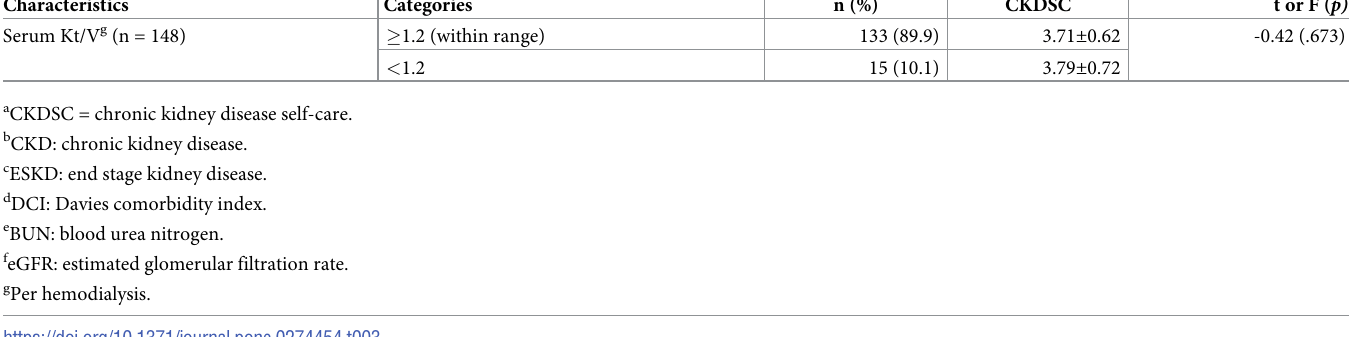
The model derived by analyzing the effect of the participant’s characteristics and health literacy on CKDSC using a linear multiple regression analysis was significant, and there was no multi- collinearity (Durbin–Watson statistic, 1.93, tolerance, .18–.93, variance inflation factor, 1.08– 5.52). The variables of current unemployed status (B = .16), non-smoker status (B = .32), end- stage kidney disease (B = .31), and the “actively managing my health” scale (B = .41) signifi- cantly affected the CKDSC score, and their explanatory power was 32.7%. The variable “age 65 years or older” (B = .14), although not significantly affected by CKDSC, was near the signifi- cant level ( p = .059) (Table 5).